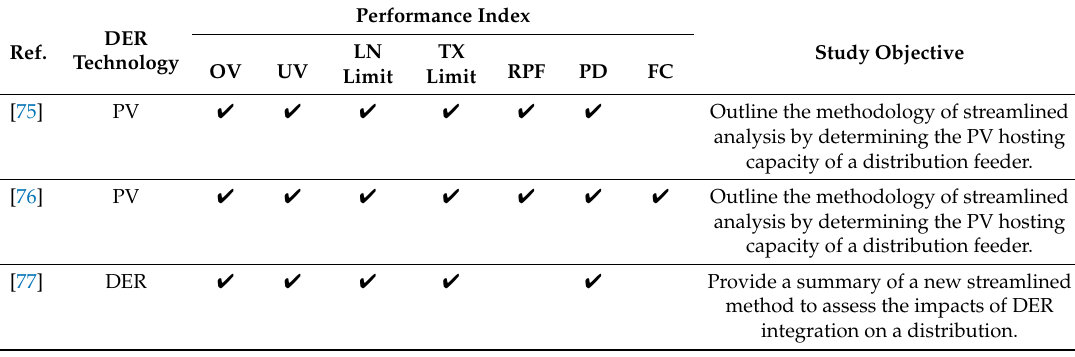
Table 5. Studies that utilize the streamlined method for hosting capacity evaluation.